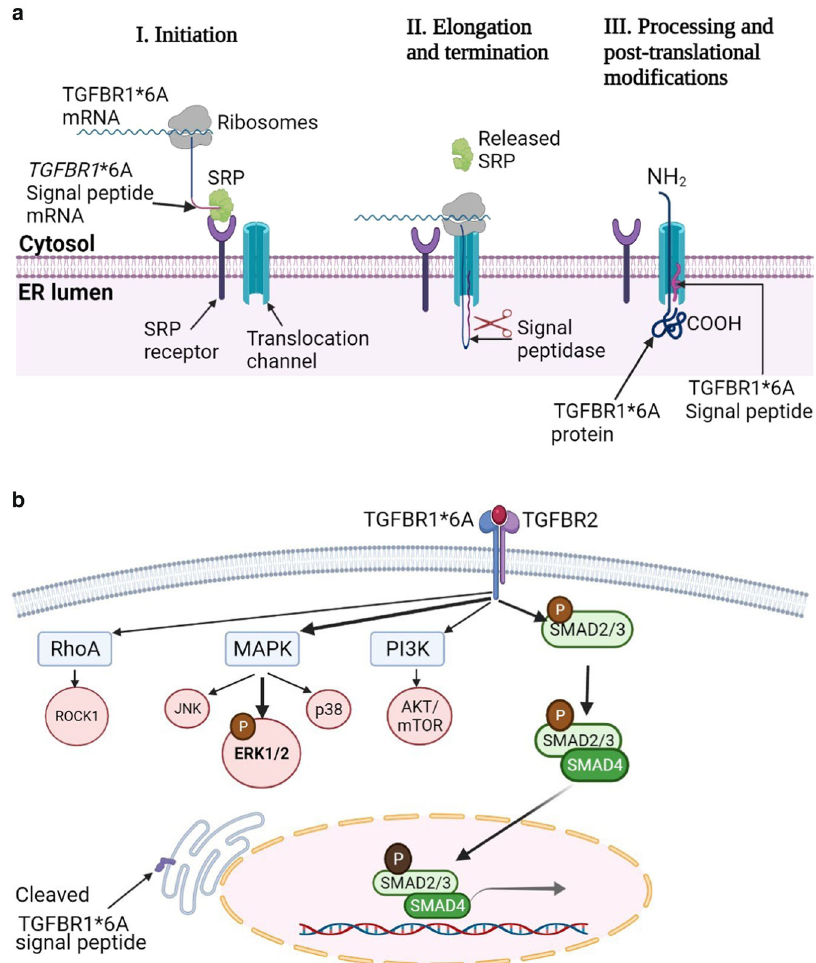
Fig. 3 Schematic showing the role of TGFBR1*6A signal peptide. a TGFBR1*6A protein translation and processing, the TGFBR1*6A signal peptide is cleaved between Ala30 and Leu31, whereas the wild-type TGFBR1 is cleaved between Ala33 and Leu34. Both TGFBR1*6A and TGFBR1 wild-type exhibit similar binding af fi nity to TGFB ligand and stability (half-life). The TGFBR1*6A signal peptide also demonstrates similar protein targeting and translocation functions as the wild-type. b TGFBR1*6A intracellular signaling, TGFBR1*6A maintains intact TGF- β signaling to induce growth and migration in breast cancer cells. It shows similar TGF- β signaling as wild-type TGFBR1 but enhances phosphorylation of ERK1/2 to induce its tumor-promoting